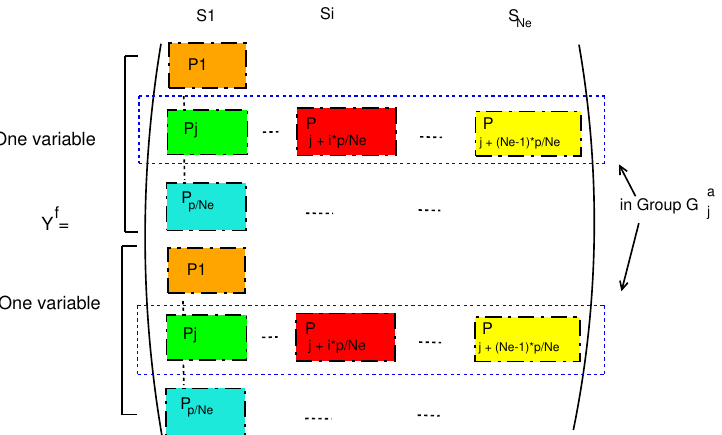
Figure 4. The entries of the matrix Y f on different processors in case N e < = p . S i ( i = 1, · · · , N e ) denotes the i th ensemble member. P i ( i =1, · · · , p ) denotes the i th